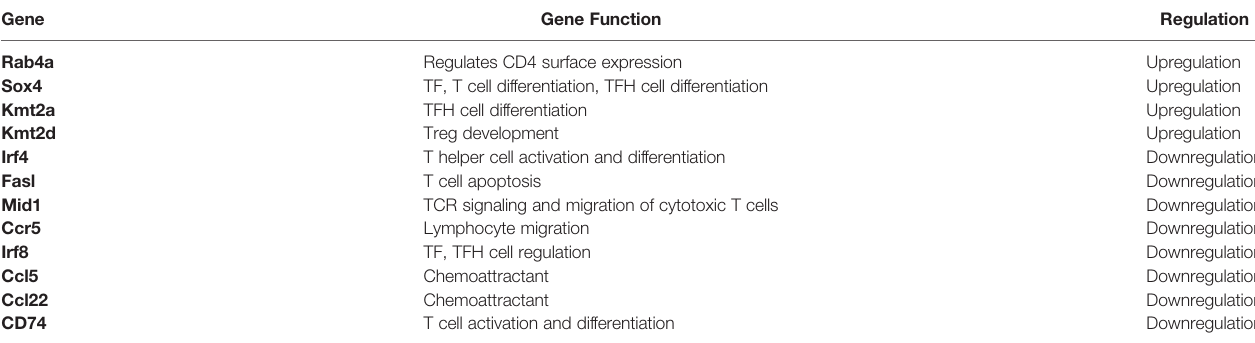
TABLE 1 | Top DEGs in Pou2af1 fl / fl x CD4-Cre mice compared to CD4-Cre